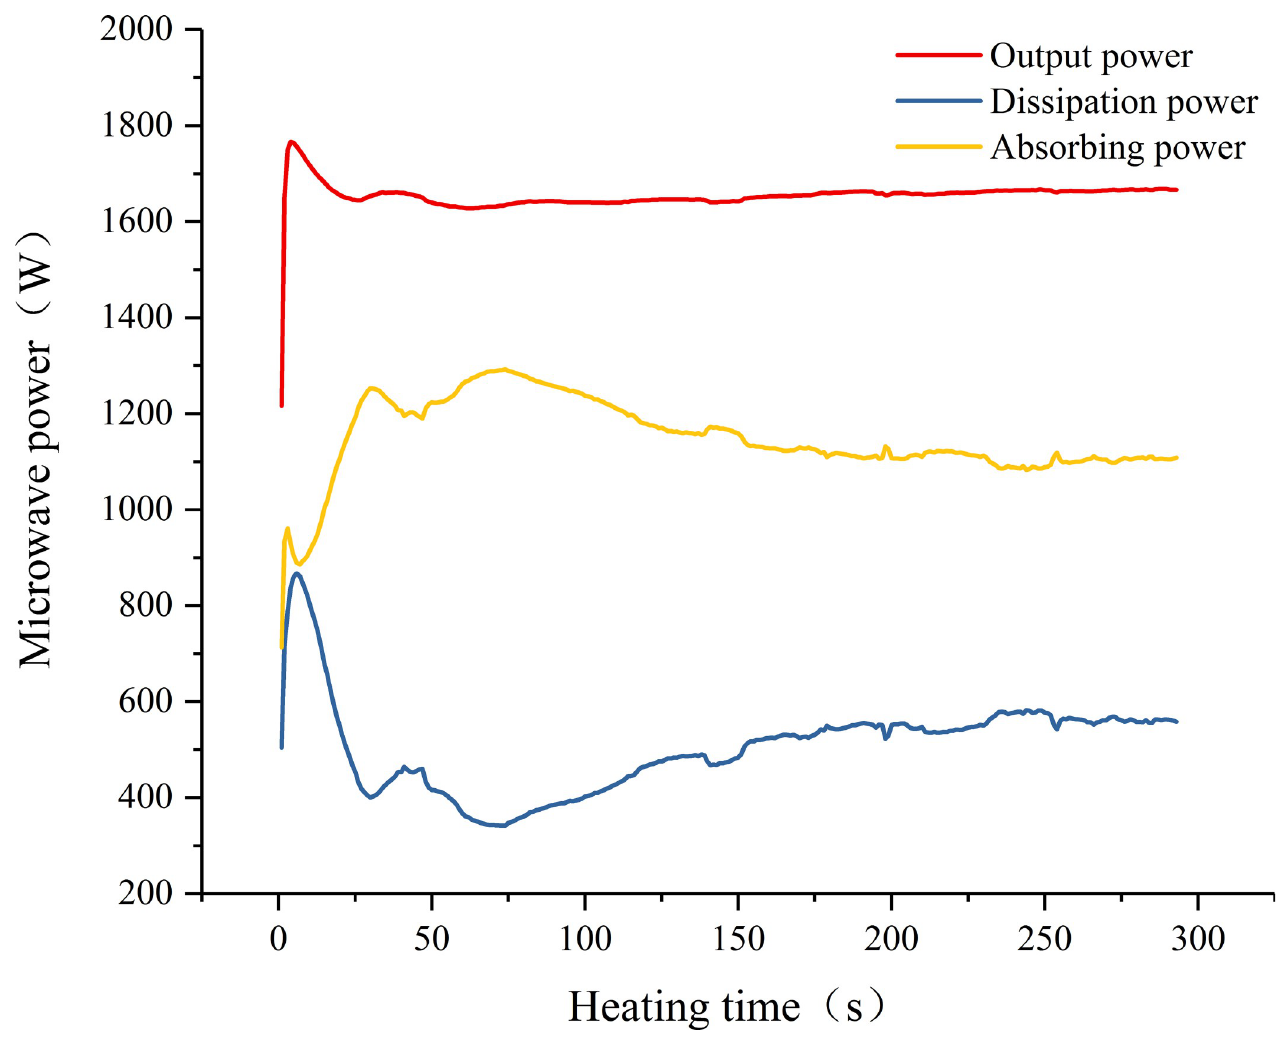
Fig 7. Microwave power versus heating time curve of sample